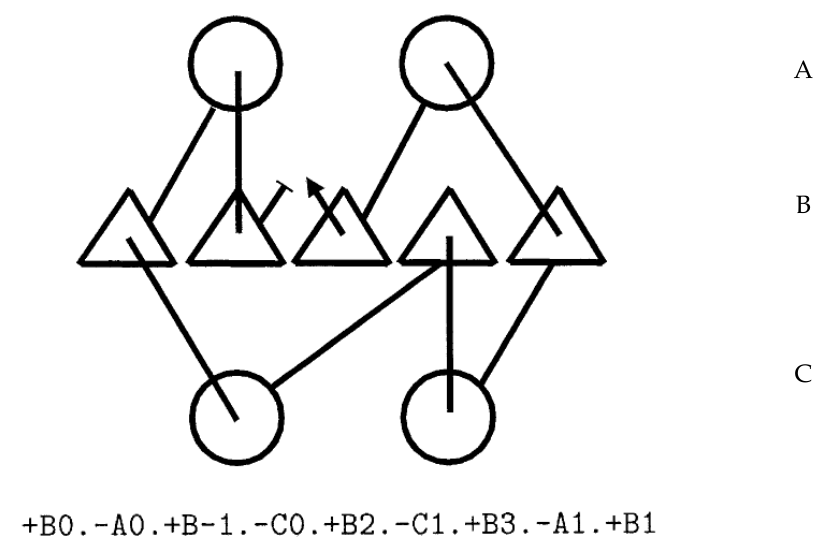
Figure 3. Topology diagram and string. The encoding of a topology diagram into a string is described in the text. In the diagram, helices are circles and strands are triangles. The three secondary structure layers (alpha / beta / alpha) are encoded as A / B / C in the string and secondary structure elements (SSEs) are numbered left to right in each layer.